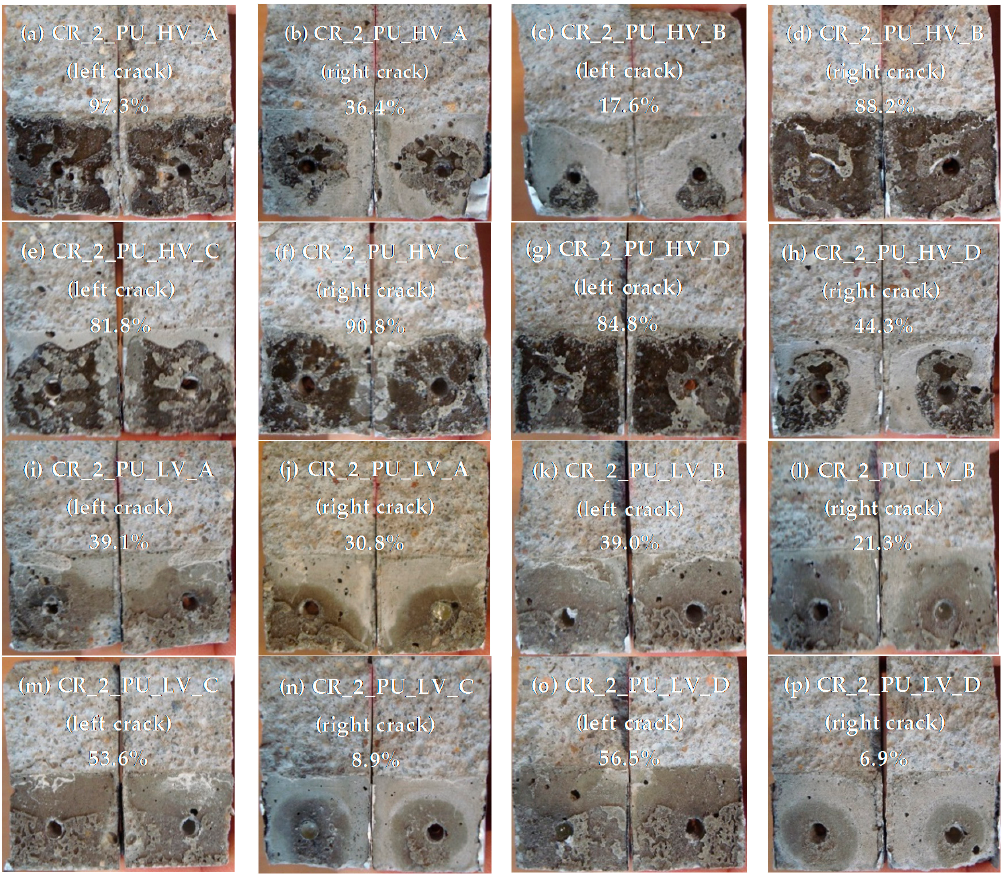
Figure 23. Visualization of the spread region of the healing agents in the crack for mortar prisms with two healed cracks. Mean surface coverage of both crack faces is indicated for the cracks of each individual